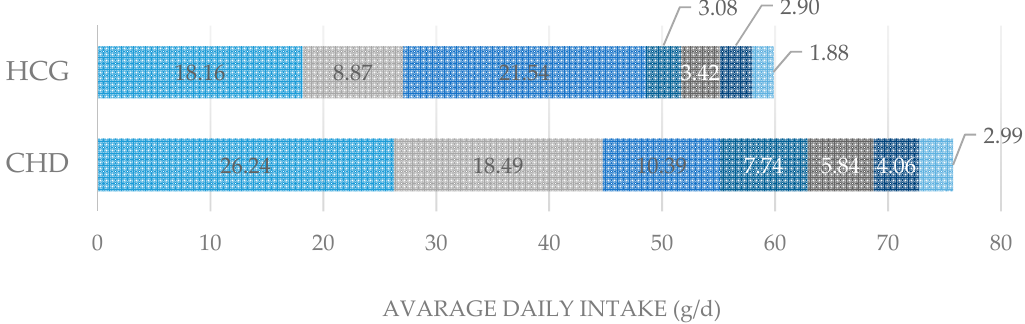
Figure 2. Average daily consumption of cariogenic food among CHD children and controls in gram per day (g/d).